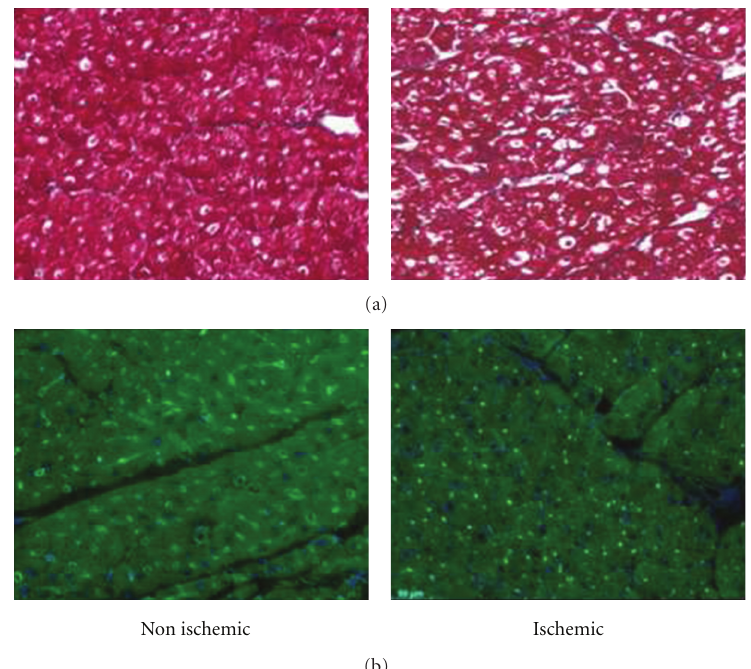
Non ischemic Ischemic